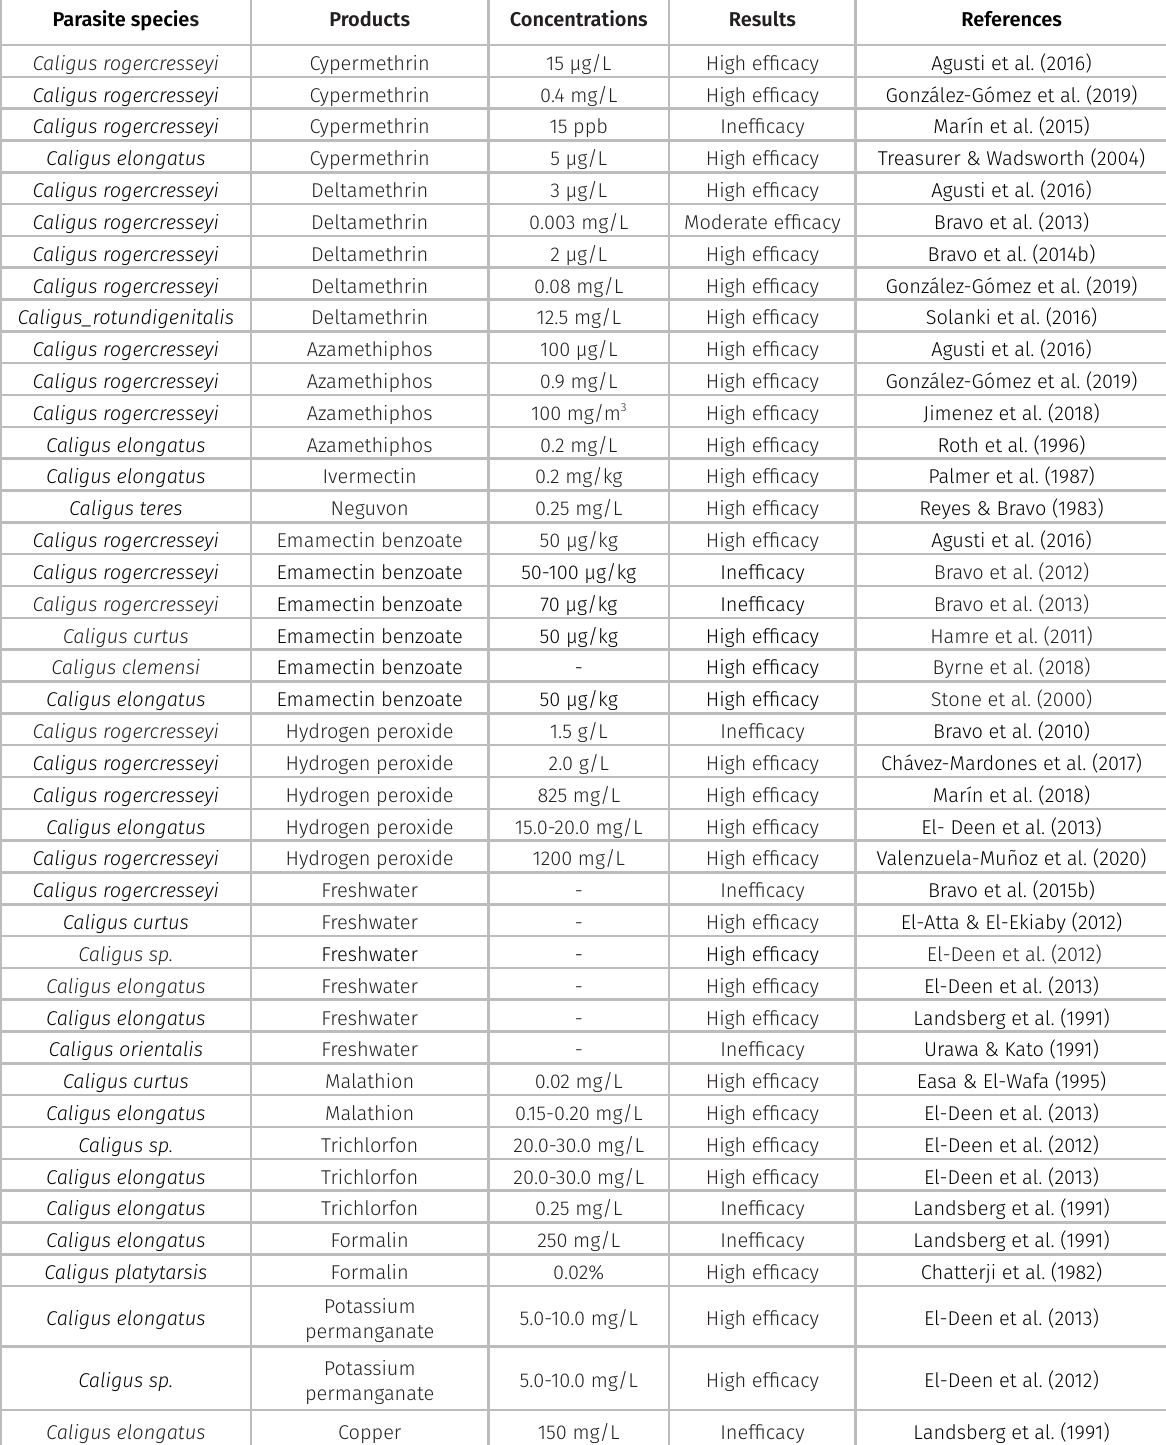
Table IV. Management strategies with chemotherapeutic products to control and treatment of infestation by Caligus spp. in different teleost